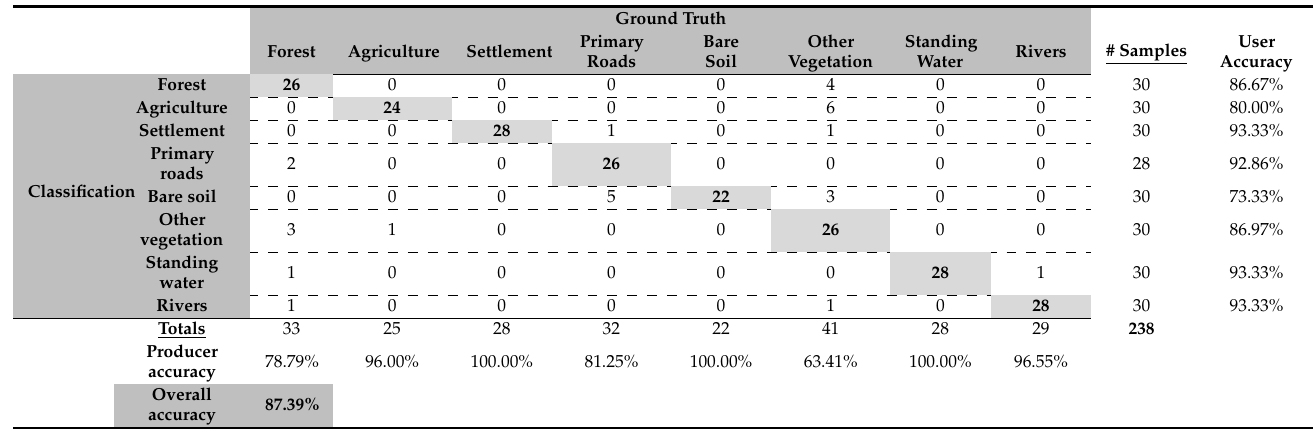
Table 6. Validation Matrix for Service 1: LULC classification for epoch 2002.